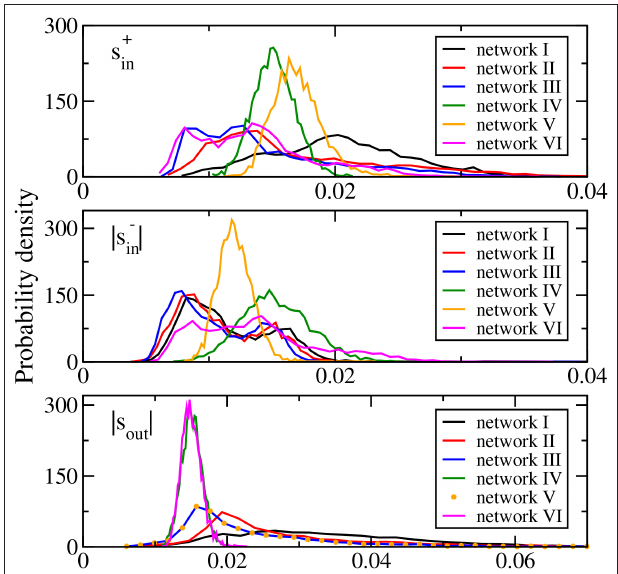
FIGURE 1 | Distributions of average synaptic weights s + in (upper panel), | s − in | (middle panel), and | s out | (bottom panel) for the six networks studied. In the bottom panel, the distribution of | s out | of network VI is identical to that of network III and is thus denoted by symbols.